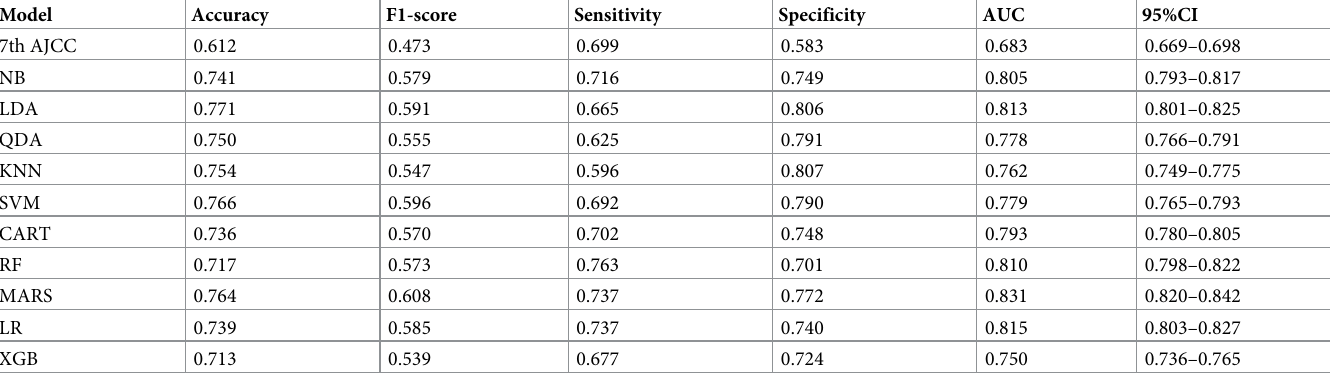
Table 2. The accuracy, F1-score, sensitivity, specificity, and AUC value of 10 ML algorithms and 7th AJCC stage in the test set. Model